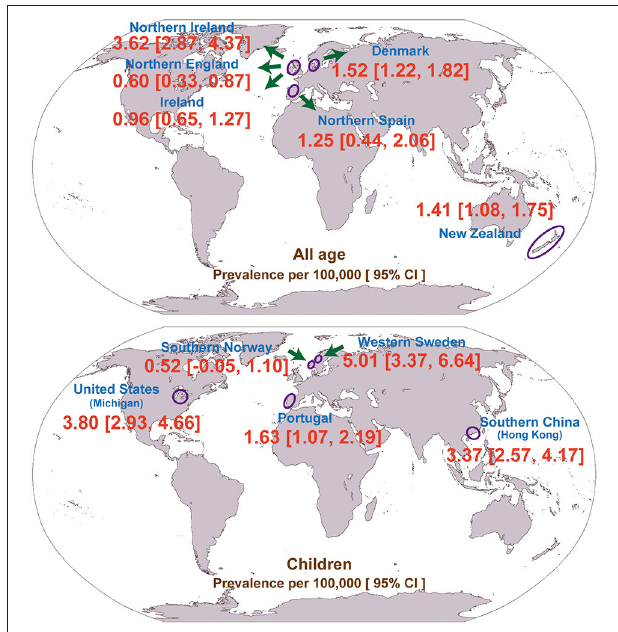
FIGURE 3 | Geographical distribution of the prevalence of congenital